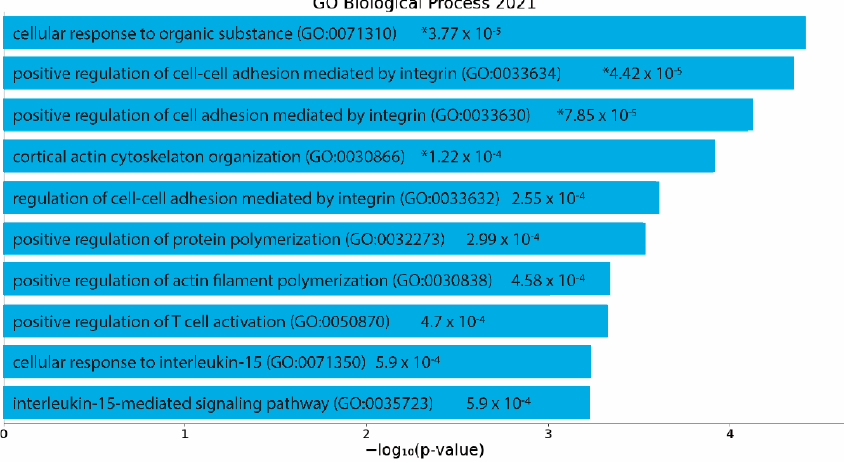
Figure 6. EnrichR analysis of differentially expressed genes ( p adjusted < 0.05) with an absolute log2 fold change greater than 1. Gene ontology as determined via “GO Biological Process 2021”. p -values are listed on figure. *: adjusted p < 0.05.